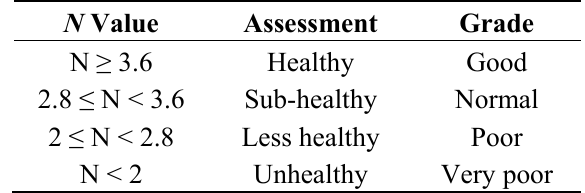
Table 6. Comprehensive evaluation of quantitative grading